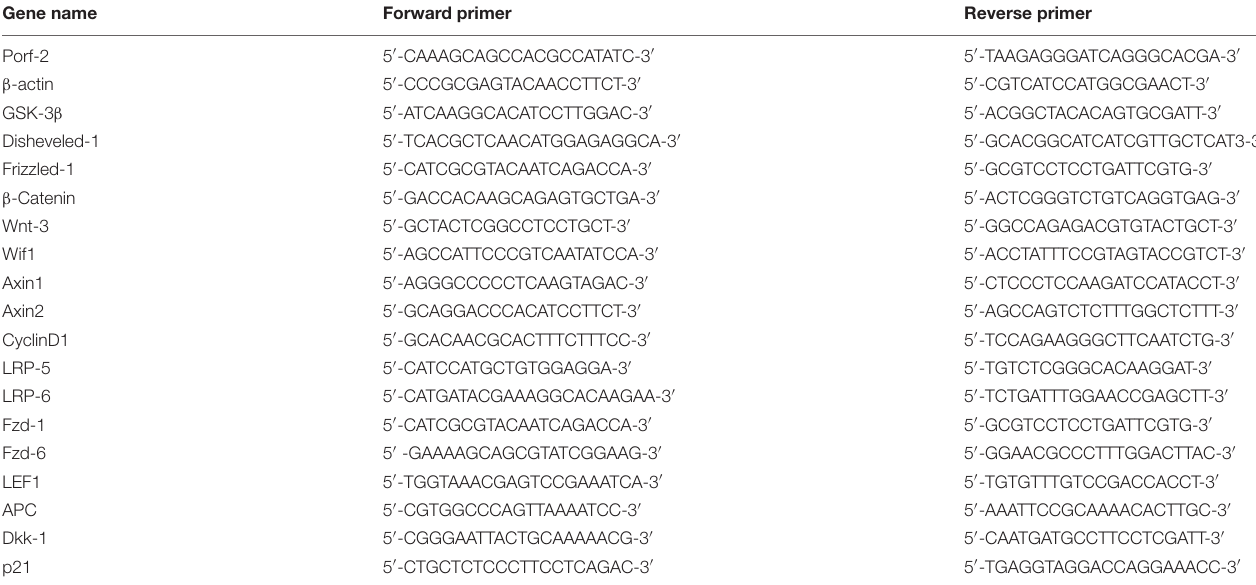
TABLE 1 | Primer sequences used for quantitative real-time